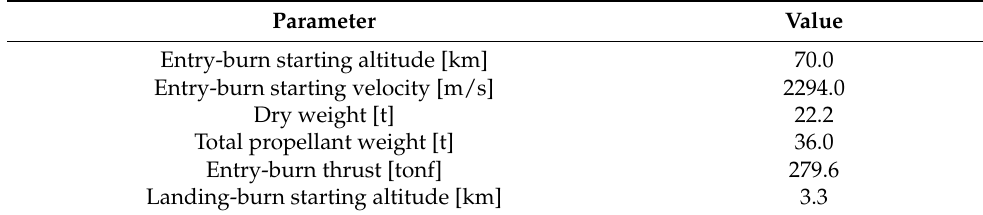
Table 7. Specification and initial condition of Falcon 9